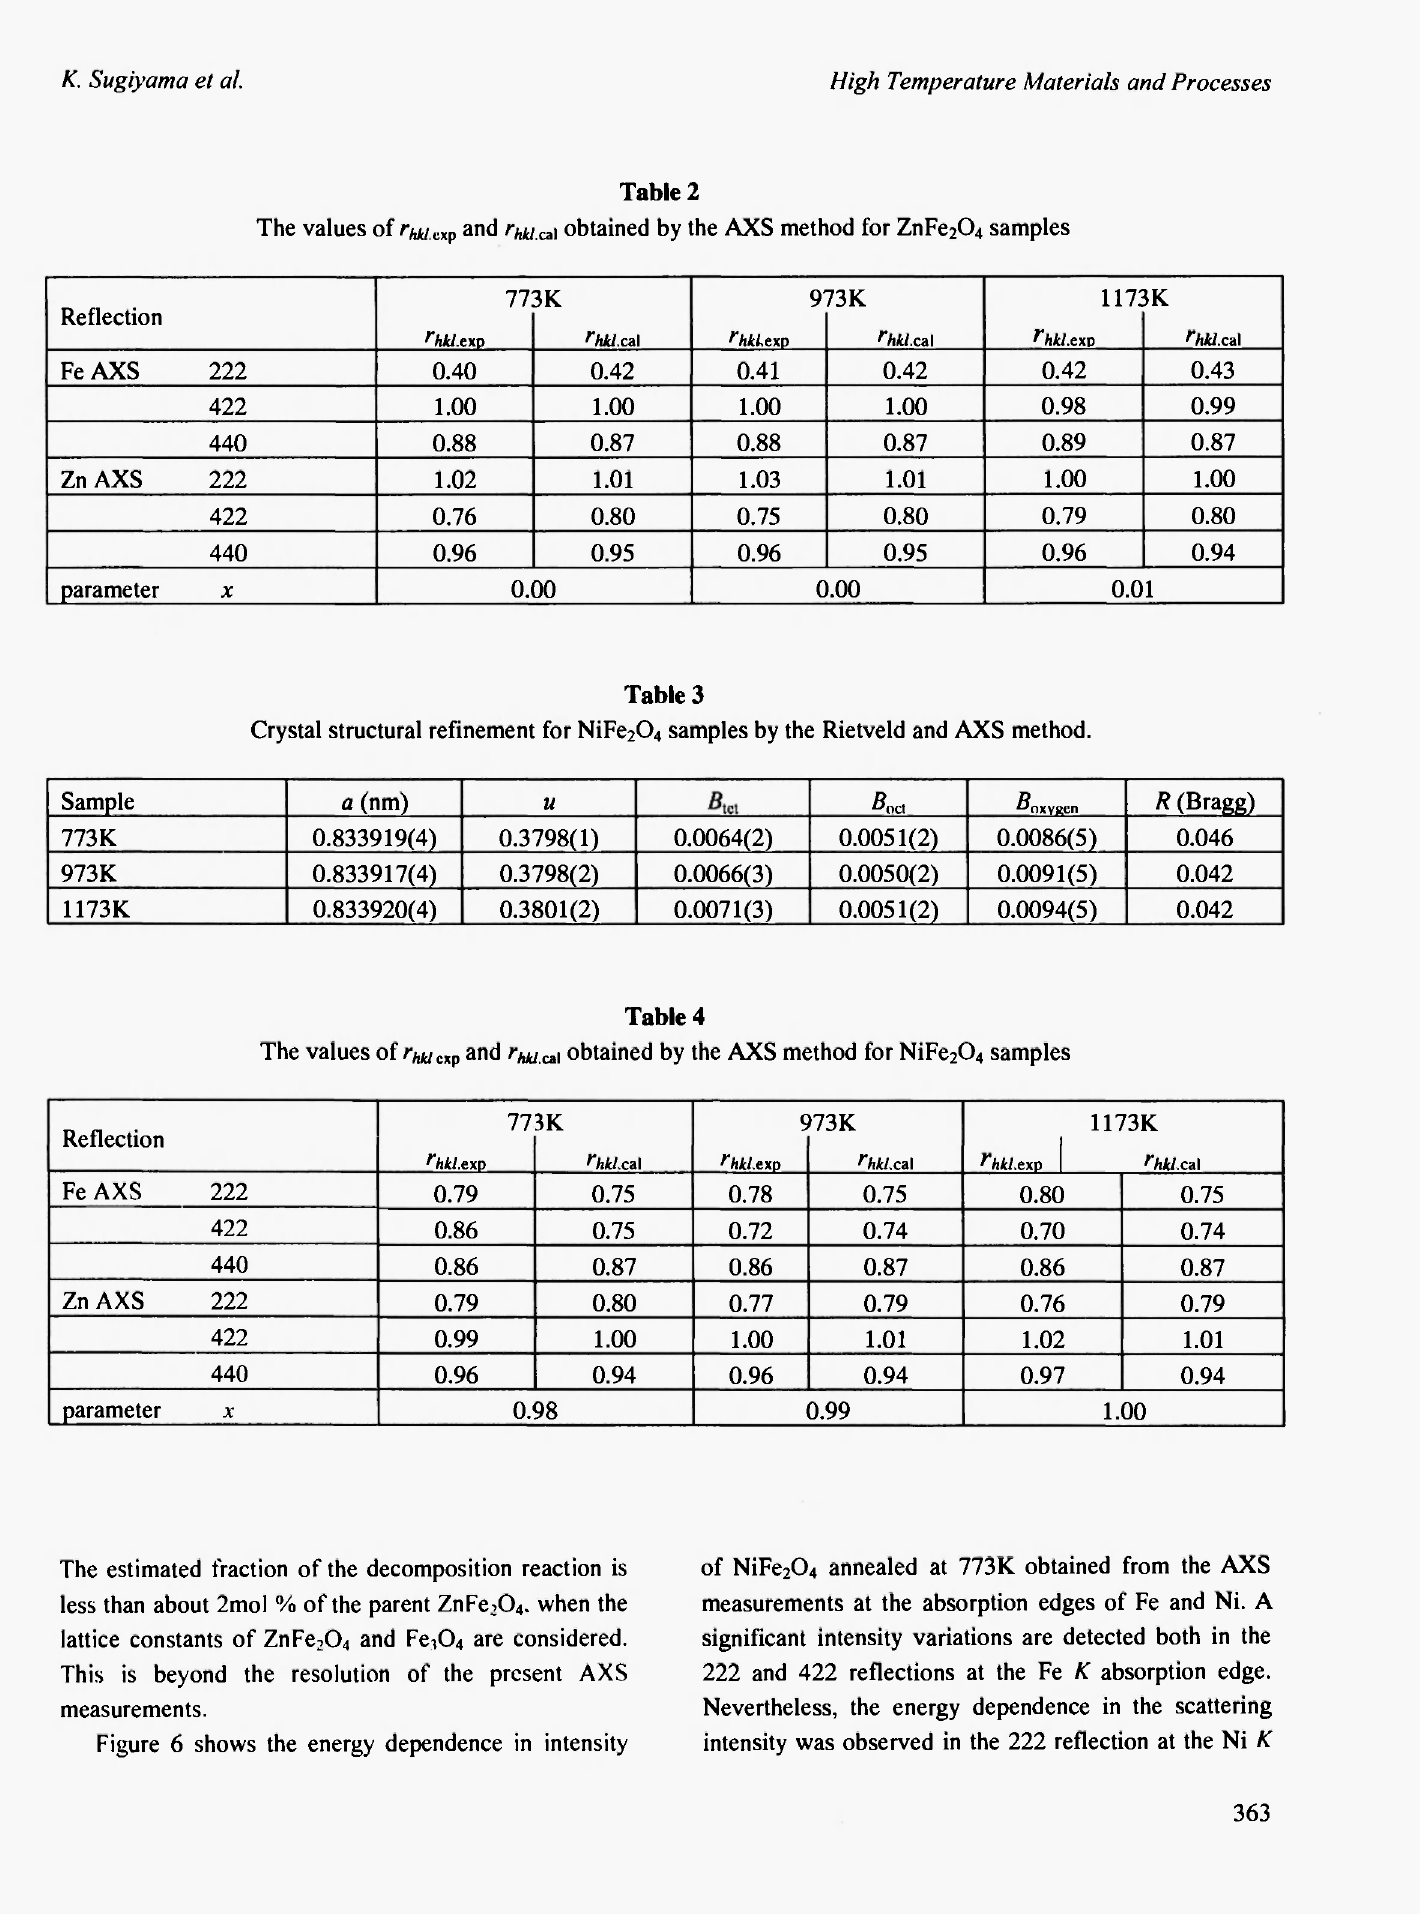
The values of r hUm p and r m aA obtained by the AXS method for NiFe 2 0 4